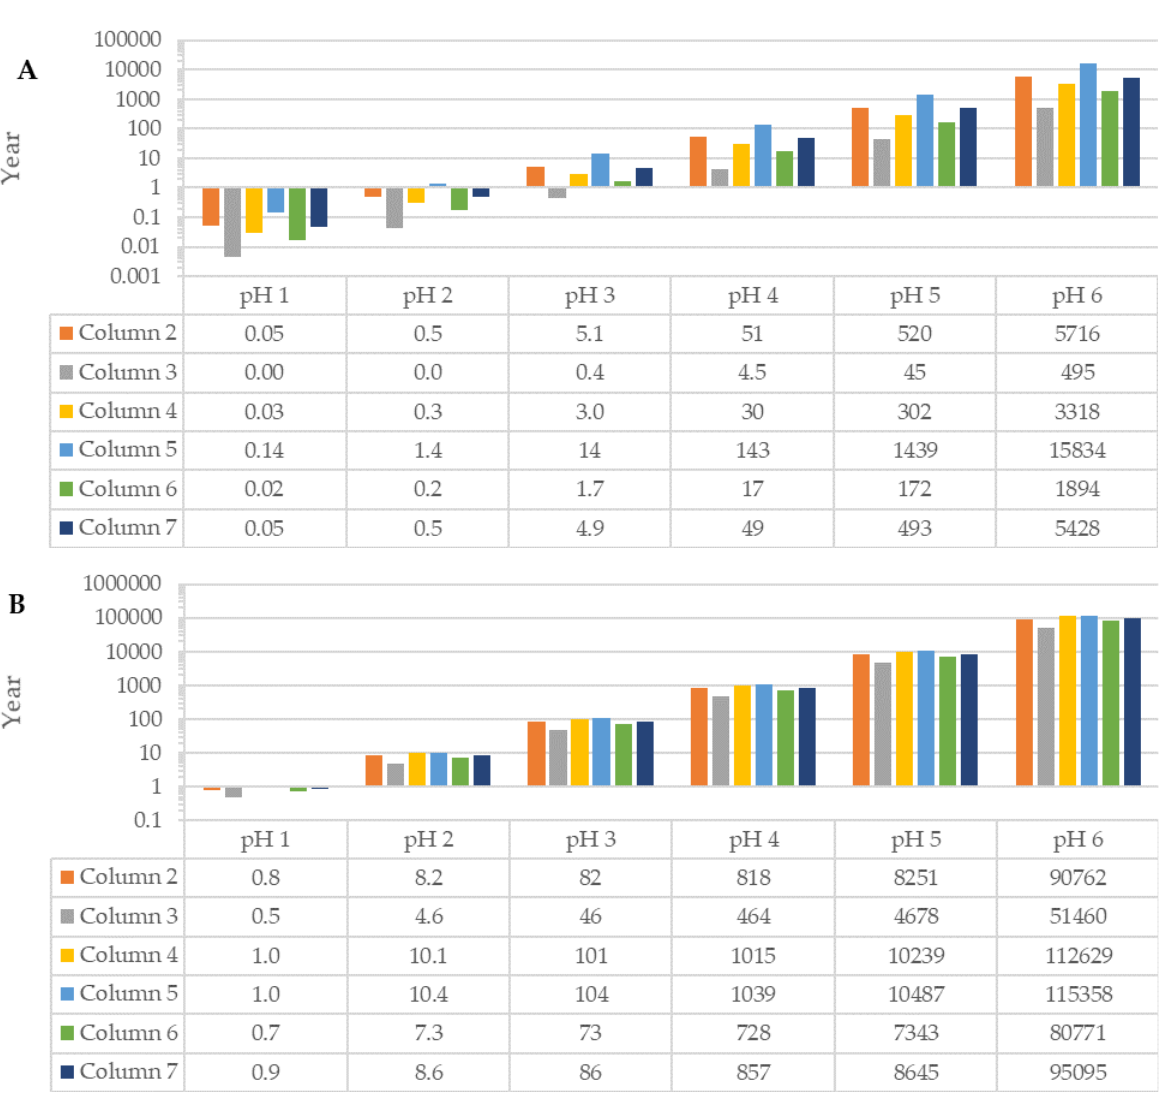
Figure 6. Log graphs and tables showing the theoretical abiotic neutralization capacity values of a horizontal flow gravity-fed biological sand reactor system with flow rates based on: ( A ) Column experiments (this study), and ( B ) in-situ flow rates in a pilot biological sand reactor system as previosuly described [8]).